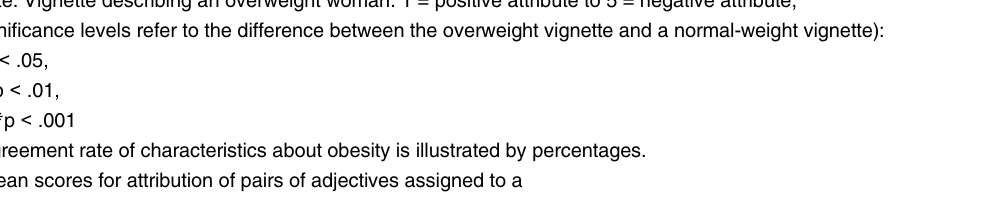
Table 3 summarizes specific characteristics and their prevalence.